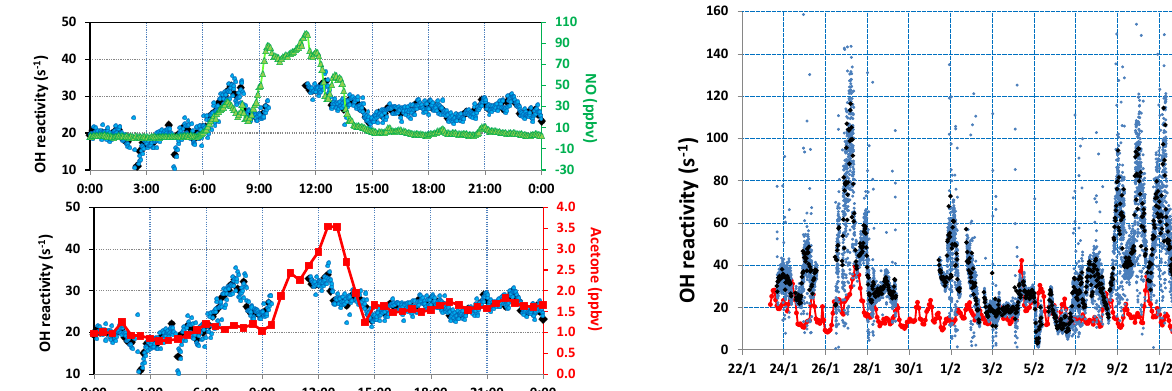
Figure 89. Daily variability of the OH reactivity during a local pollution episode: top panel: OH 3 Fig. 9. Daily variability of the OH reactivity during a local pollution reactivity time series (2min blue dots and 10min black diamonds) and NO time series (5min 4 episode: top panel: OH reactivity time series (2min blue dots and green triangles). Bottom panel: OH reactivity time series (2 min blue dots and 10 min black 5 10 min black diamonds) and NO time series (5min green triangles). diamonds); acetone time series (30 min red squares). 6 Bottom panel: OH reactivity time series (2 min blue dots and 10 min black diamonds); acetone time series (30 min red squares).